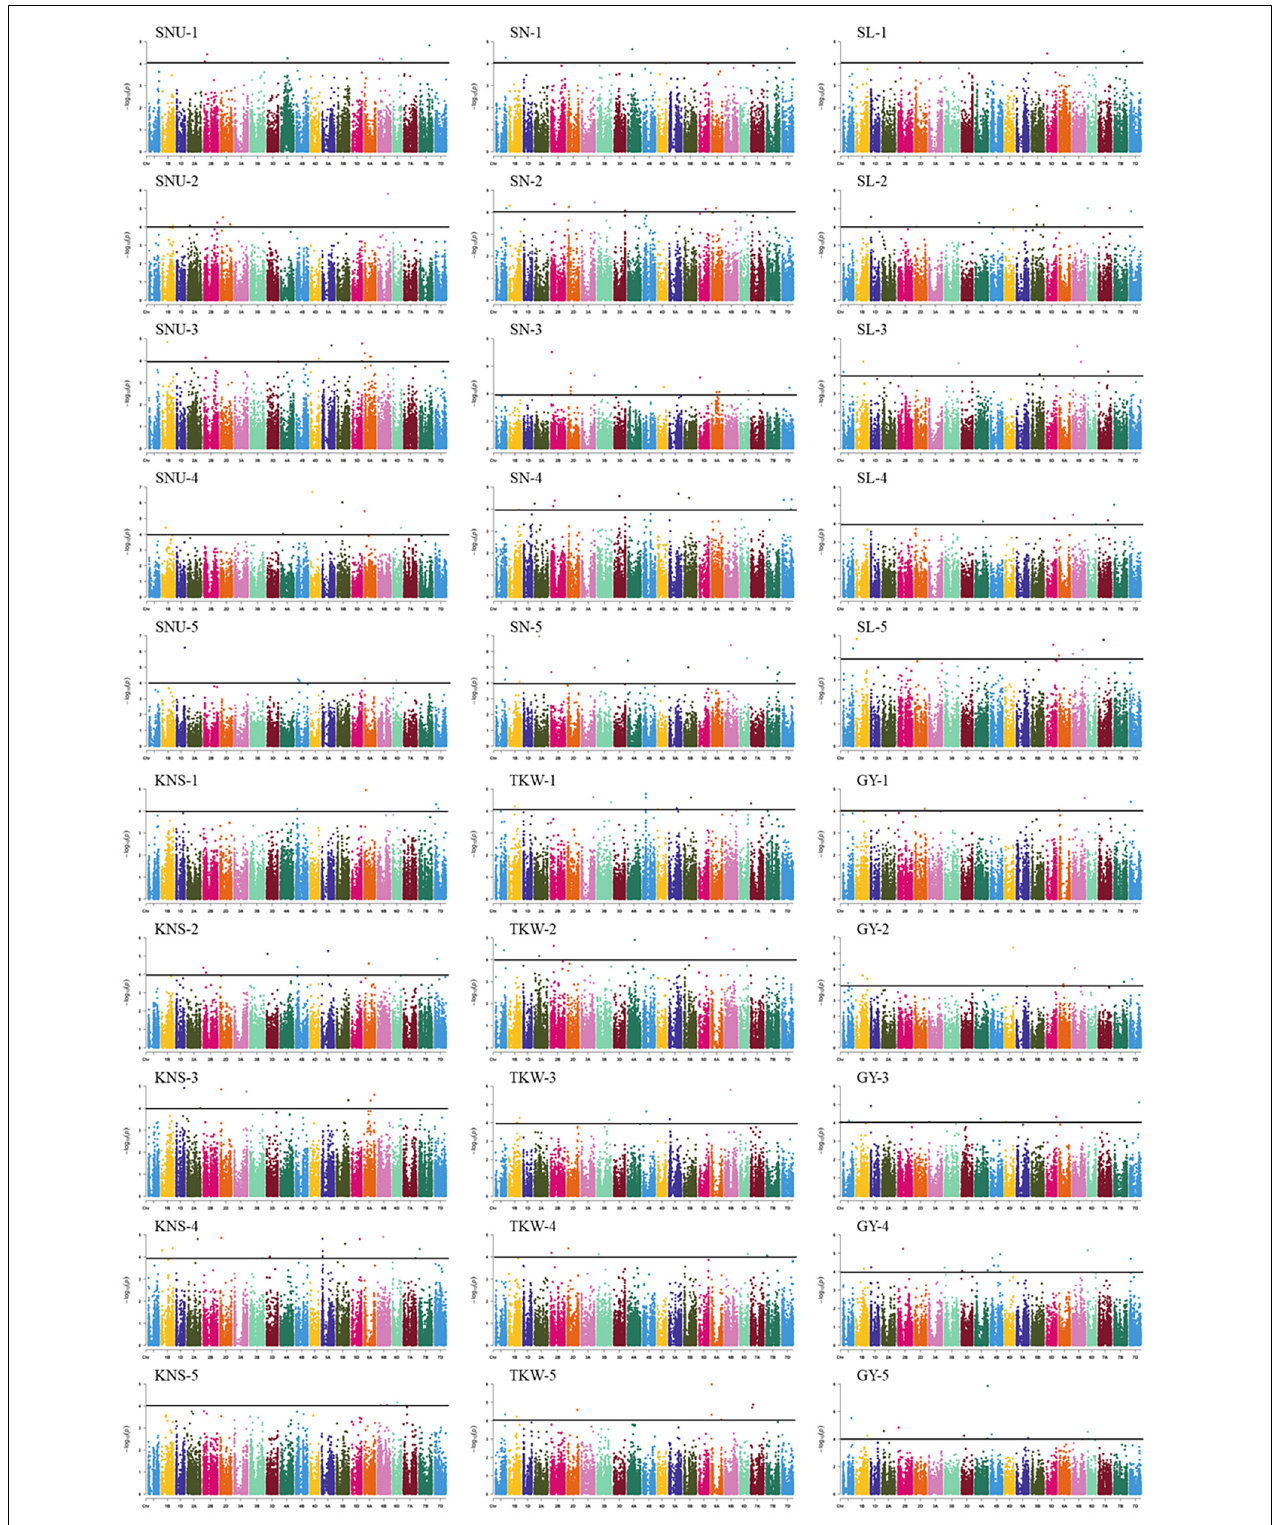
FIGURE 2 | Manhattan plot for GY-related traits in 251 wheat accessions analyzed by the MLM in Tassel v5.0. SNU, spike number per unit area; SN, spikelet number; SL, spike length; KNS, kernel number per spike; TKW, thousand-kernel weight; GY, grain yield. The 1, 2, 3, 4, and 5 indicated the Haerbin, 2018, 2019; Keshan, 2018, 2019, and the best linear unbiased prediction (BLUP).